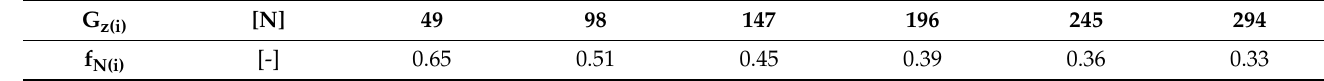
Table 12. Numerical values of friction coefficient f N [-].